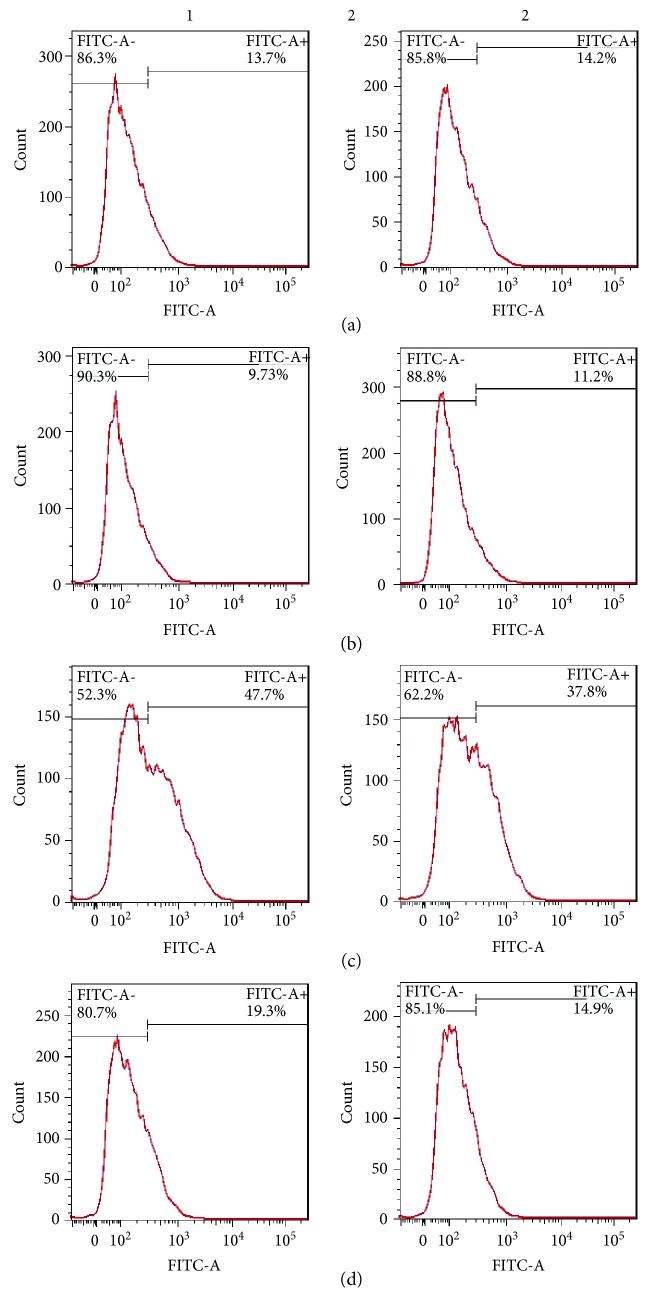
ROS changes in L-02 cells after arsenic and/or grape seed procyanidin extract treatment for 24 h. The more the number of FITC-A+ cells, the more the ROS in the cells: (a1) the control group, (a2) the 10 mg/L GSPE group, (b1) the 25 mg/L GSPE group, (b2) the 50 mg/L GSPE group, (c1) the arsenic (25 μM) group, (c2) the arsenic (25 μM) + 10 mg/L GSPE group, (d1) the arsenic (25 μM) + 25 mg/L GSPE group, and (d2) the arsenic (25 μM) + 50 mg/L GSPE group.